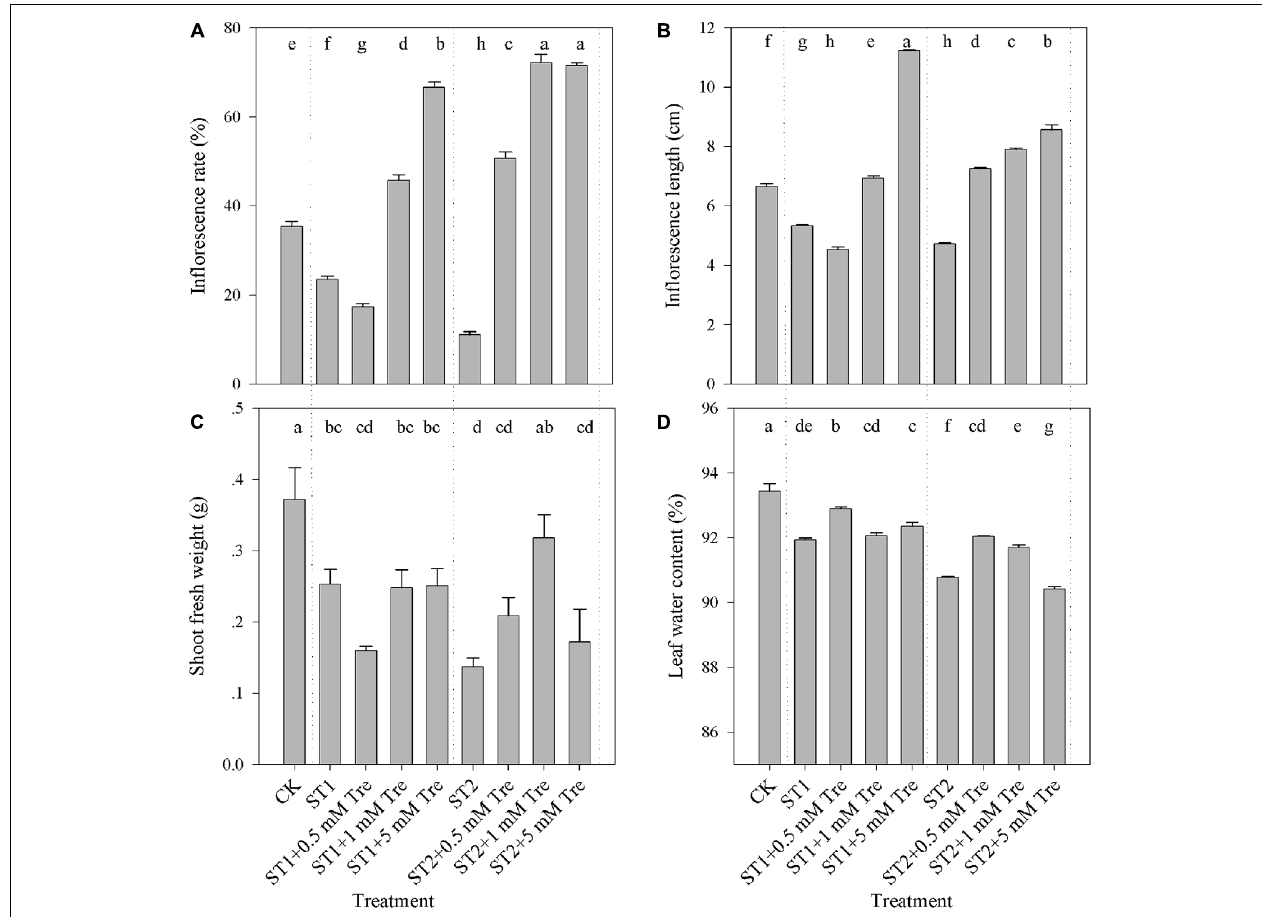
FIGURE 1 |The vegetative and reproductive growth affected by salinity andTre in Arabidopsis . (A) Flowering rate (%); (B) Inflorescence length; (C) Shoot fresh weight; (D) Leaf water content.The results showed are the